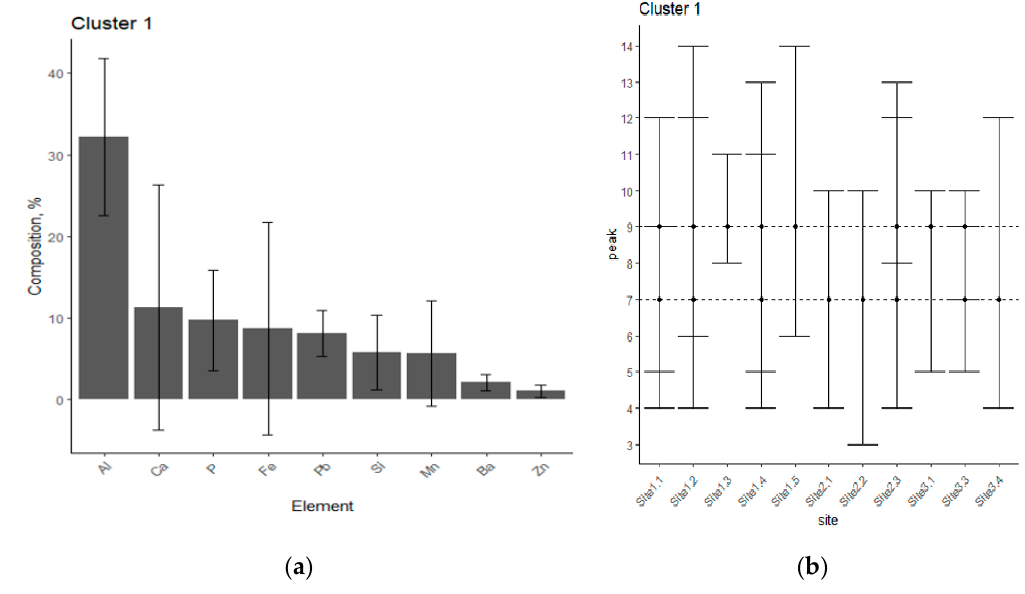
Figure 4. ( a ) Average chemical composition and standard deviation of the components in cluster 1; ( b ) extraction peak location and their windows of extraction for cluster 1 components.